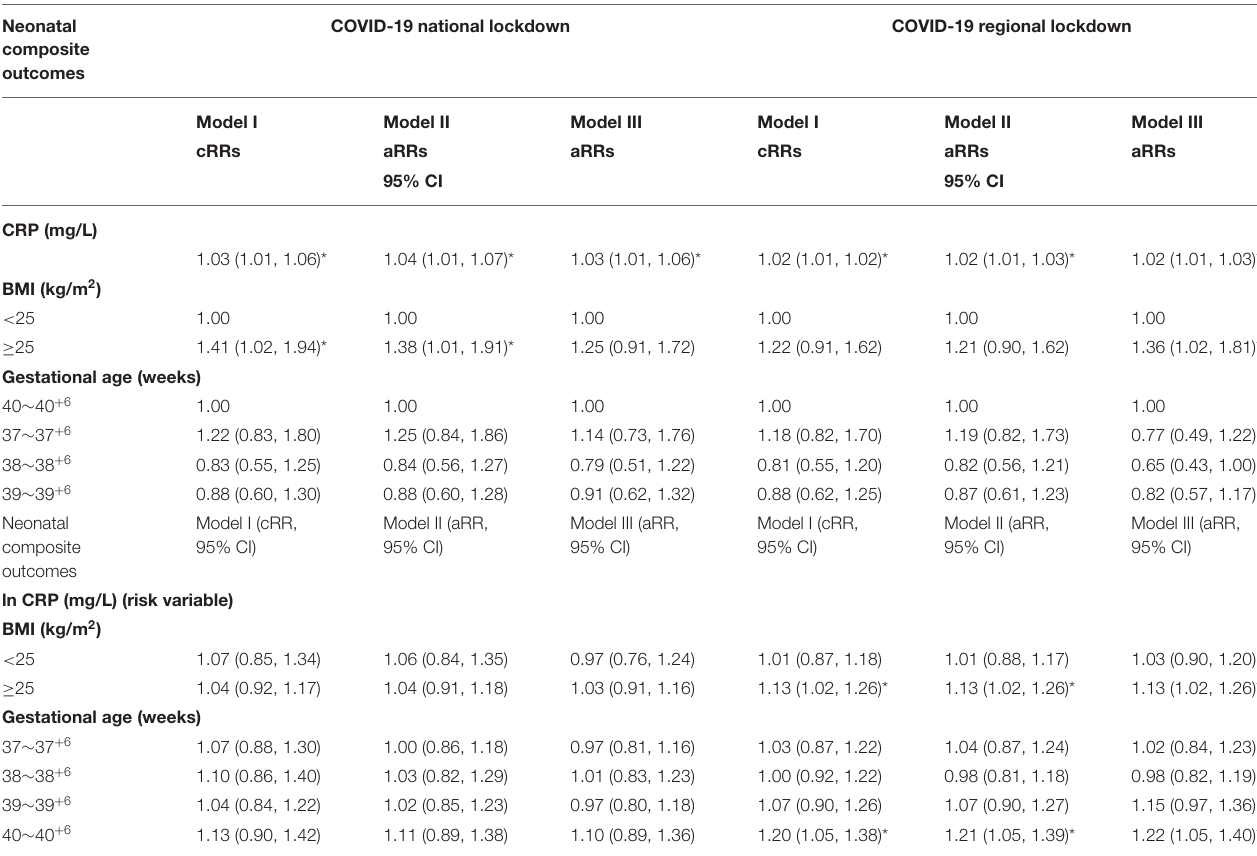
TABLE 4 | Correlation of CRP, BMI, gestational age with neonatal complications, CRP, and neonatal complications under BMI and gestational age subgroups. Neonatal